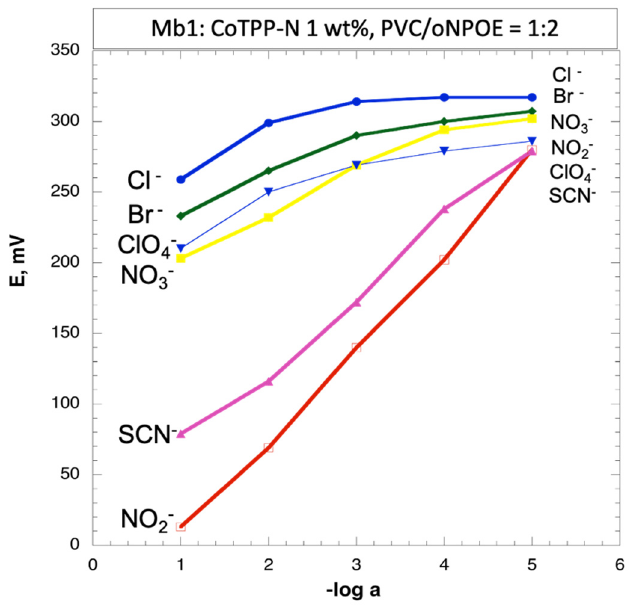
Figure 4. Calibration curves of PVC/o-NPOE membrane Mb1 doped with 1 wt.% of CoTPP-N 294 without any ion exchanger addition. Measurements in 0.01 M MES buffer solution, pH 5.5. 295 The response curve of the membrane Mb1 toward nitrite was linear in all the tested 296 concentration ranges with a slightly super-Nernstian slope of − 66.7 ± 2.3 mV/dec. The anti- 297 Hofmeister selectivity pattern of NO 2- > SCN - > NO 3 - > ClO 4 - > Br-> Cl- was observed for 298